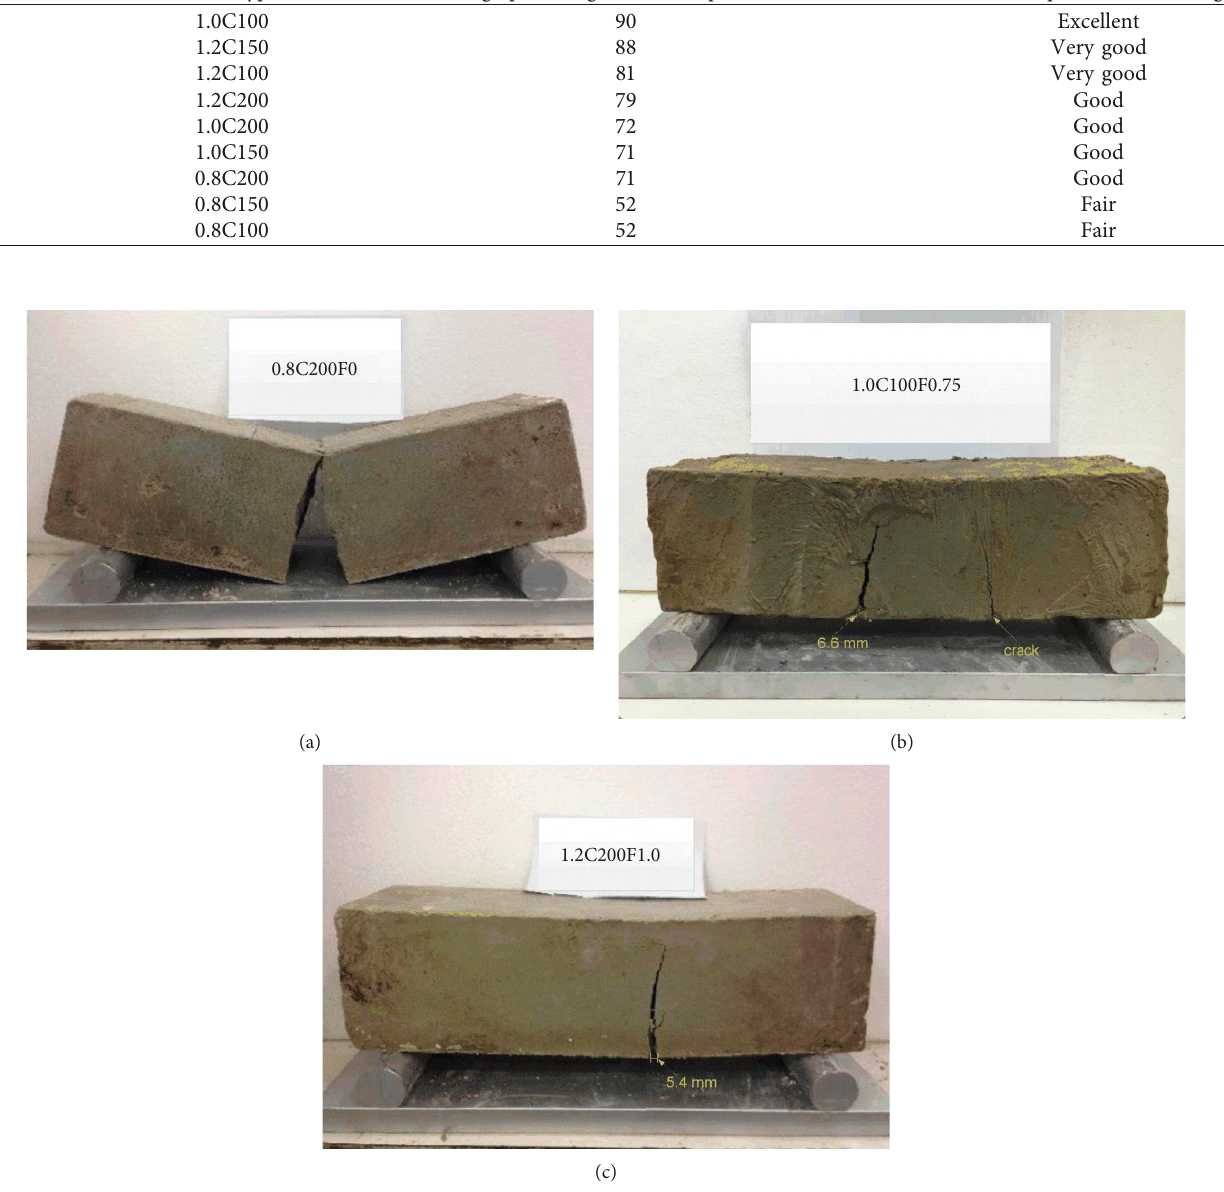
Table 6: Rank of the effectiveness of each mixing proportion used in this study based on an overall performance rating. Rank